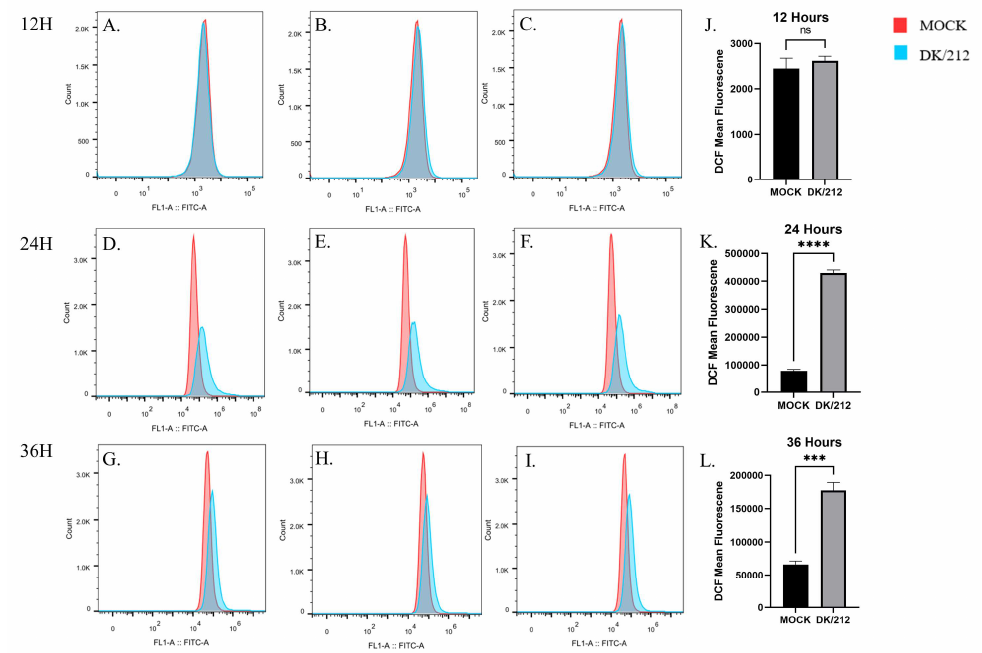
Figure 1. H5N1 subtype highly pathogenic avian influenza virus (DK/212) infection induced oxidative stress in A549 cells. ( A , B , C ) DK/212 virus infection and control in A549 cells at 12hpi. ( D , E , F ) DK/212 virus infection and control in A549 cells at 24 hpi. ( G , H , I ) DK/212 virus infection and control in A549 cells at 36 hpi. Mean DCF fluorescence was determined via Flow cytometry as described in the methods. All data were expressed as means ± SD, the Student’s t -test was used to analyze the differences. ( ns p > 0.05, *** p < 0.001, **** p < 0.0001).